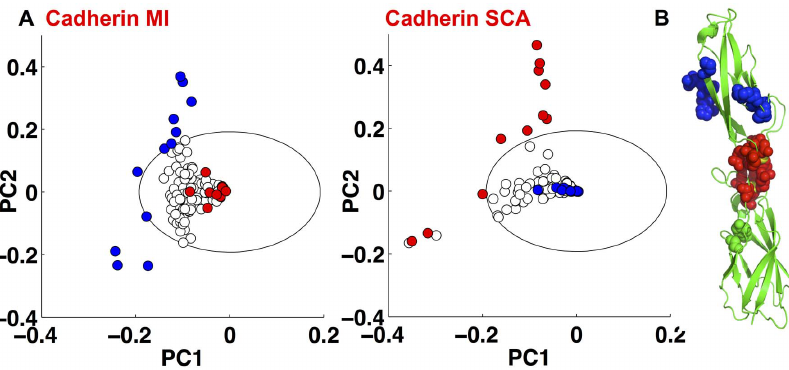
, and (right) w cons and SCA applied to the Cadherin ij ij and colored as in (A) shown on crystal structure 1EDH, note that the red sector residues form ij